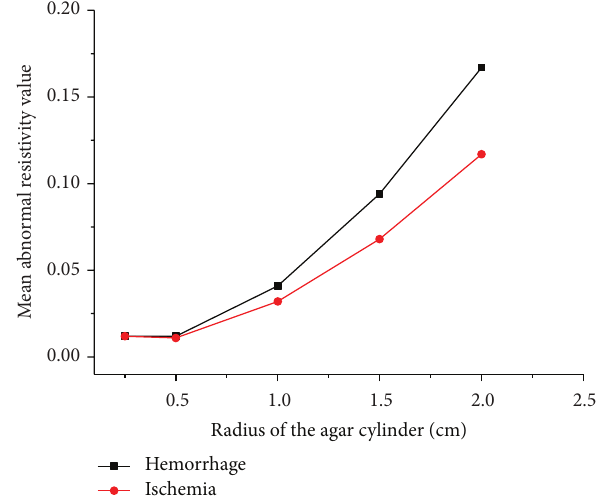
Figure 23: Mean abnormal resistivity value of ROI in each SEIT image of Figures 21 and 22 (hemorrhage for Figure 21 and ischemia for Figure 22).